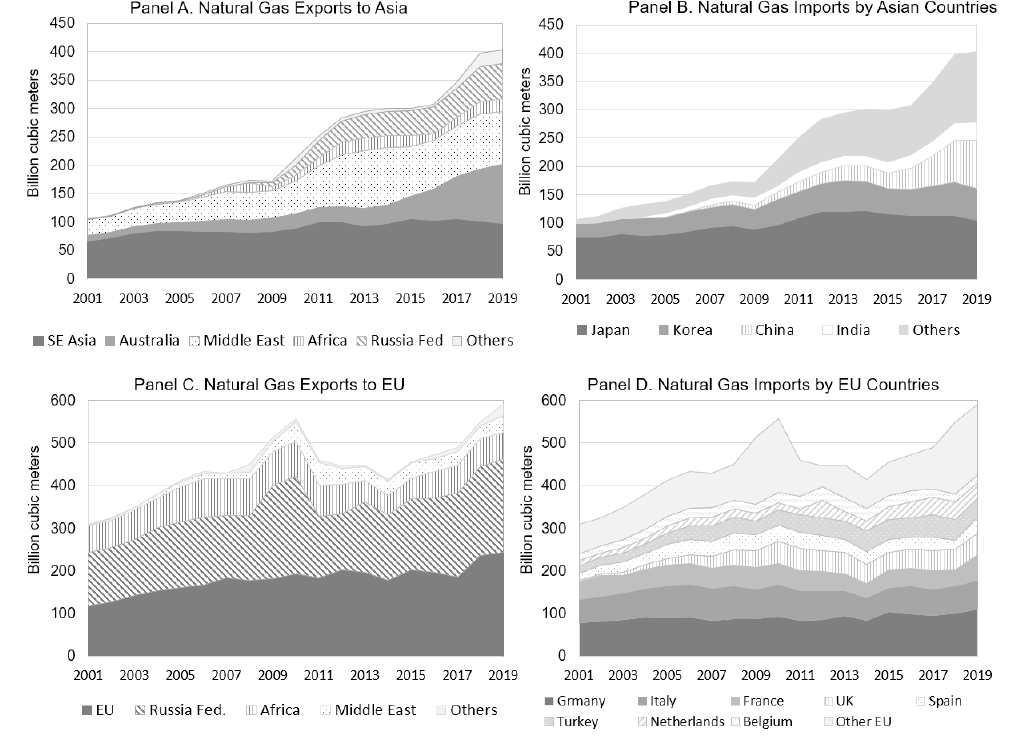
Figure 1. Exports and imports (pipeline + LNG) in Asian and European Markets. Source: BP Statistical Review of World Energy, Trade Movements, each